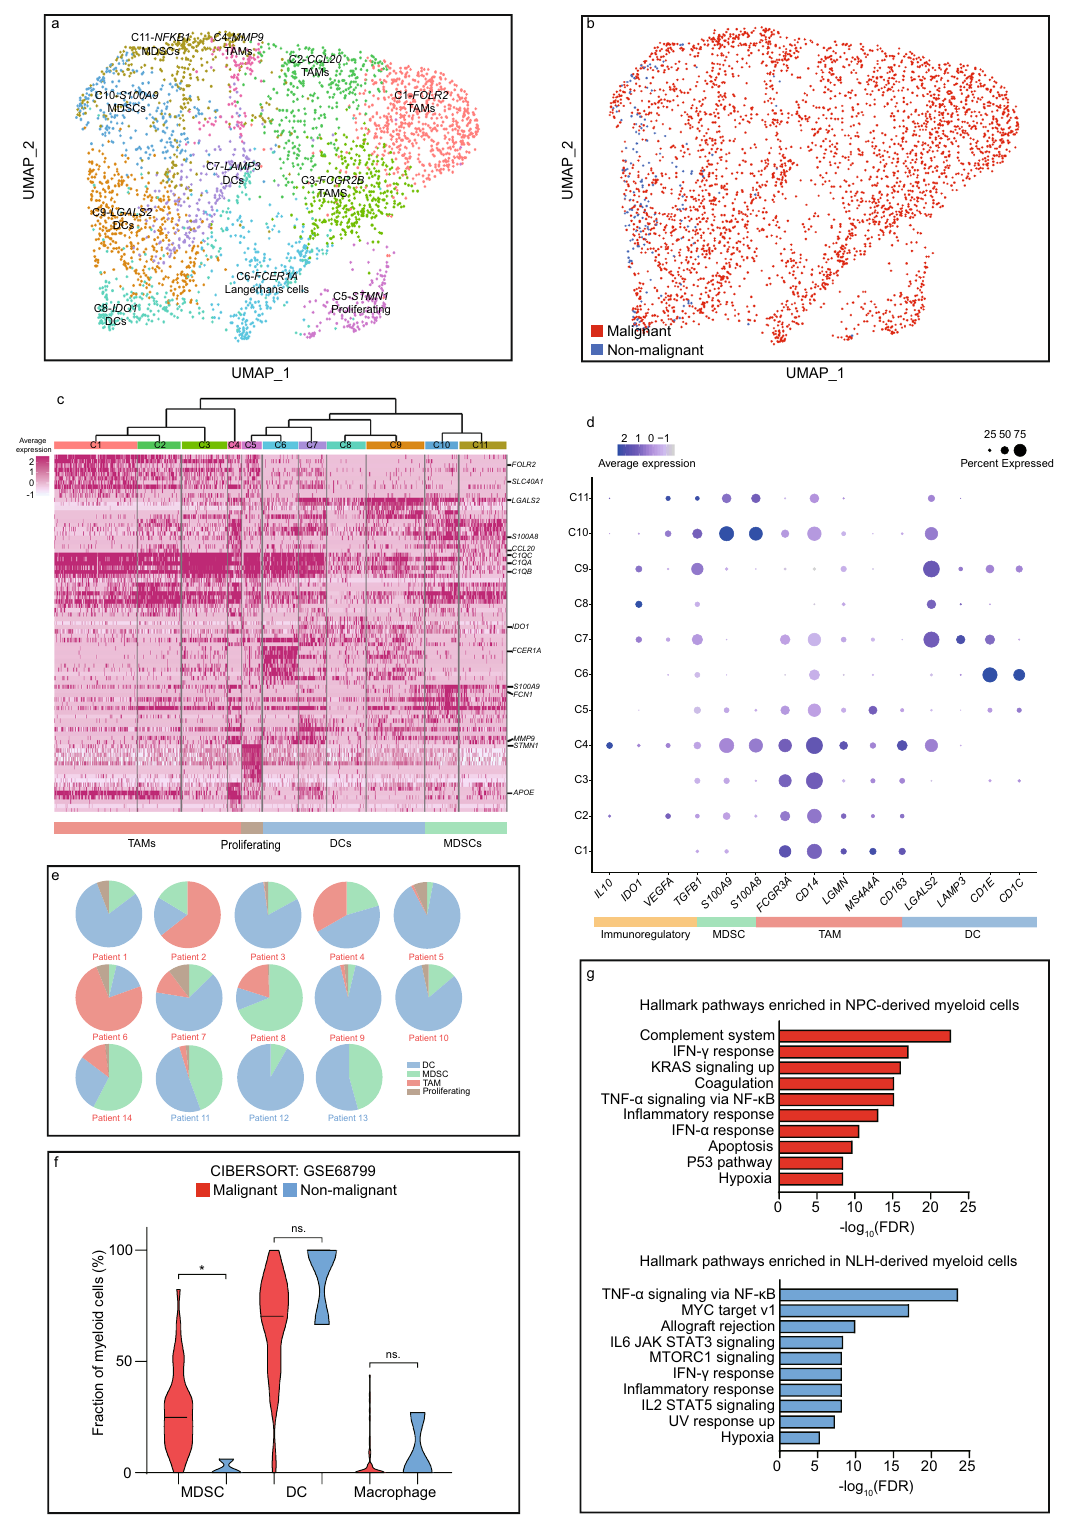
Fig. 7 The NPC microenvironment harbors suppressive myeloid subtypes with high patient-speci fi c heterogeneity. a UMAP plot of 3,671 myeloid cells, color-coded by the associated cluster. b UMAP plot of 3,671 myeloid cells, color-coded by the sample type. c The expression matrix containing the top 50 enriched genes in each subpopulation de fi ned in a , with a clustering tree categorizing related subpopulations into major subtypes. d The expression of functional signatures that were used to identi fi ed and characterized the subpopulations. e The inter-patient distribution of major myeloid subpopulations, shown by the percentage of total myeloid cells. f The estimated abundance of major myeloid subpopulations via CIBERSORTx (malignant n = 42 biologically independent samples, non-malignant n = 3 biologically independent samples). The two-sided Student ’ s t test was used to determine the statistical signi fi cance, p values > 0.05 were represented as ns. (not signi fi cant), p values ≤ 0.05 were represented as *. g The GSEA hallmark pathways enriched in NPC-derived and NLH-derived myeloid cells, ordered by − log 10 FDR. Source data are provided as a Source Data fi